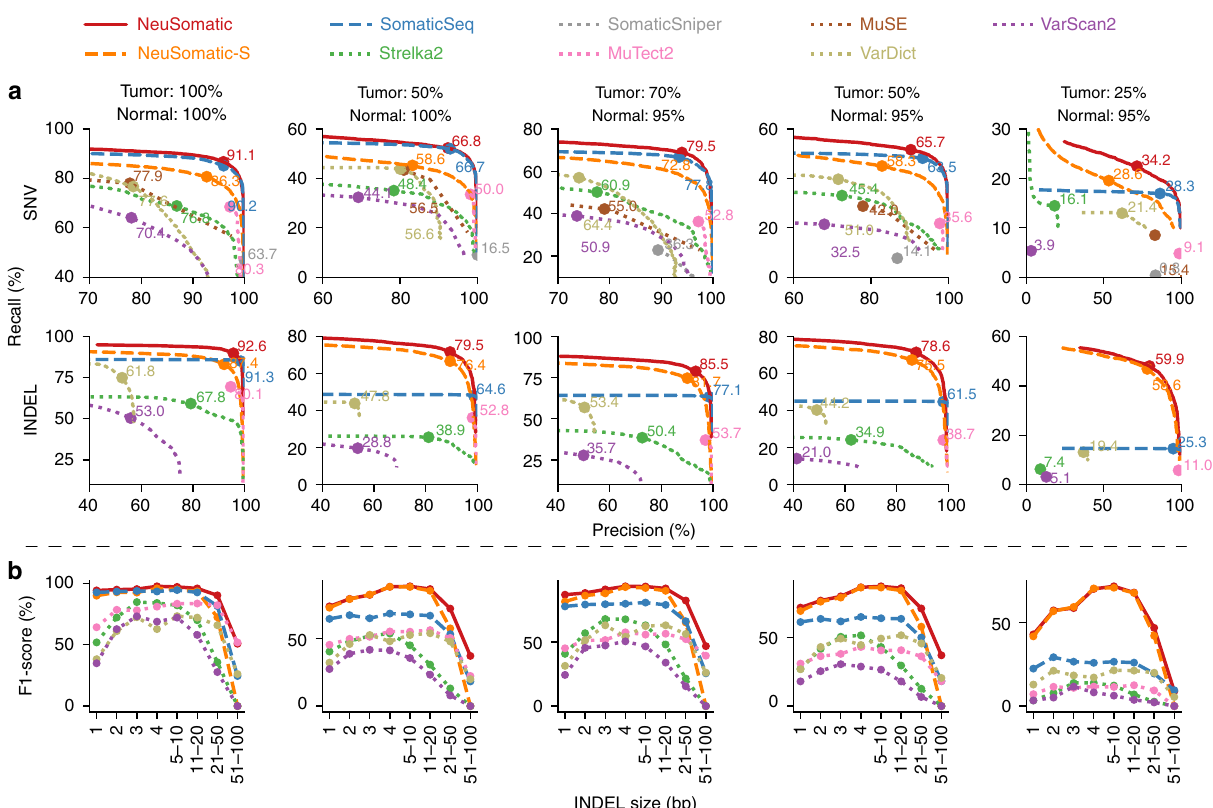
Fig. 4 Performance analysis of the DREAM Stage 4 dataset. In this dataset, fi ve tumor and normal purity scenarios (100% T:100% N, 50% T:100% N, 70% T:95% N, 50% T:95% N, and 25% T:95% N) are used. a Precision-recall analysis: the con fi dence or quality scores are used to derive the precision-recall curves. The highest F1-score achieved by each algorithm is printed on the curve and marked with a solid circle. b Performance analysis of INDEL accuracy (F1-score) for different INDEL